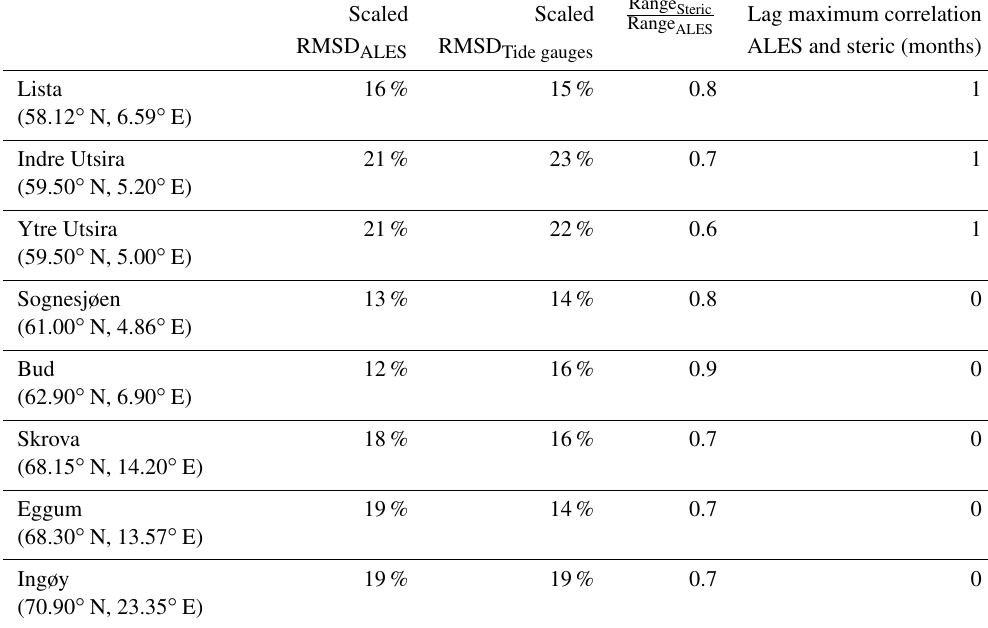
Table 1. Comparison between the seasonal cycle of SLA from ALES, of SLA from the tide gauges, and of steric sea level at each hydrographic station position. The first and the second columns show, for ALES and the tide gauges, the RMSD between the seasonal cycle of SLA and the steric sea level scaled by the range (maximum minus minimum) of the seasonal cycle of SLA. The third and the fourth columns show the ratio of the ranges and the lag of maximum correlation of the seasonal cycle of SLA from ALES and steric sea level. Lag maximum correlation Scaled Scaled Range Steric Range ALES RMSD ALES RMSD Tide gauges ALES and steric (months) 0.8